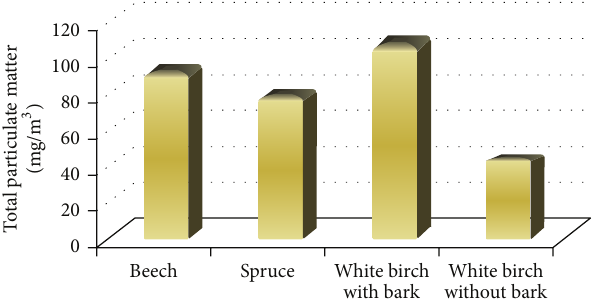
Figure 9: Concentrations of PM for different types of dendromass.